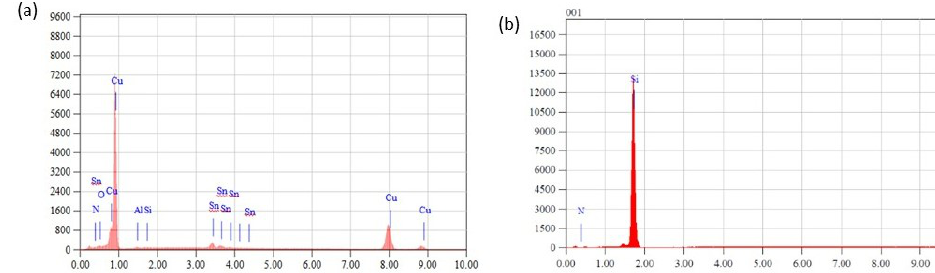
Figure 2: EDAX of (a) Base metal ‘A’ and (b) Si 3 N 4 particulates.